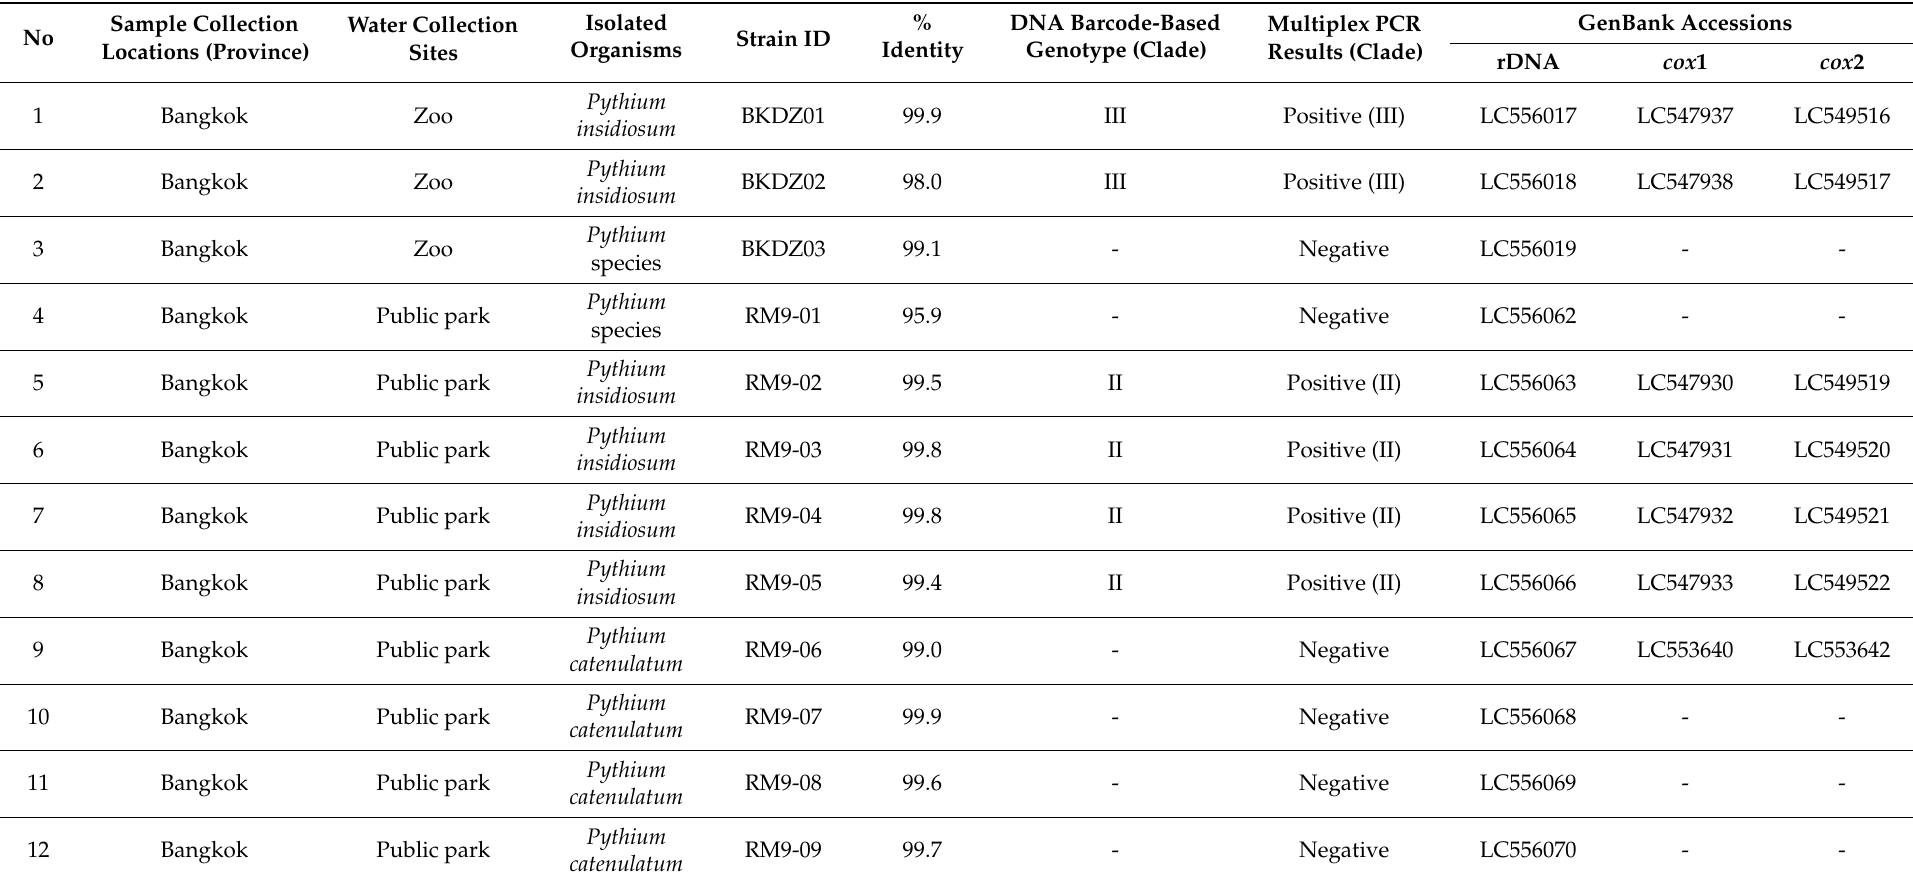
Table 4. A list of 64 culture-positive samples that show a white-to-colorless, non-sporulation, submerged colony, which is compatible with the gross morphology of P. insidiosum . The table includes sample collection locations and sites, organism identities, strain IDs, percent sequence identities, DNA barcode-based genotypes (i.e., Clade I, II, and III), multiplex PCR results (i.e., positive or negative; Clade I, II, and III), and GenBank accessions of DNA barcodes (i.e., rDNA, cox 1, and cox